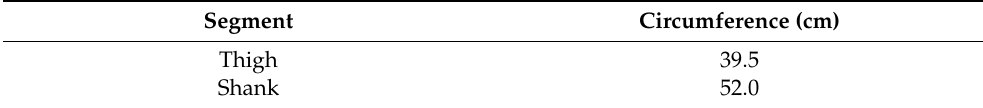
Table 2. Design parameters used to determine dimensions of wearable exoskeleton.